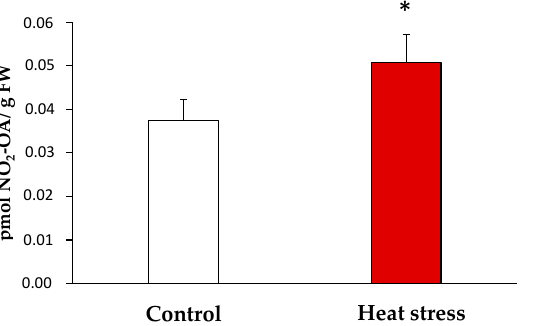
Figure 3. Endogenous levels of NO 2 -OA detected by LC-MS/MS in yeast heat stress and control samples. NO 2 -OA abundance is expressed as pmol NO 2 -OA per gram of fresh weight. The results are the mean ± SEM of at least three independent experiments. Statistical significance between means were analyzed by Student´s t -test and differences were significant when p < 0.05 (*). FW: fresh weight.